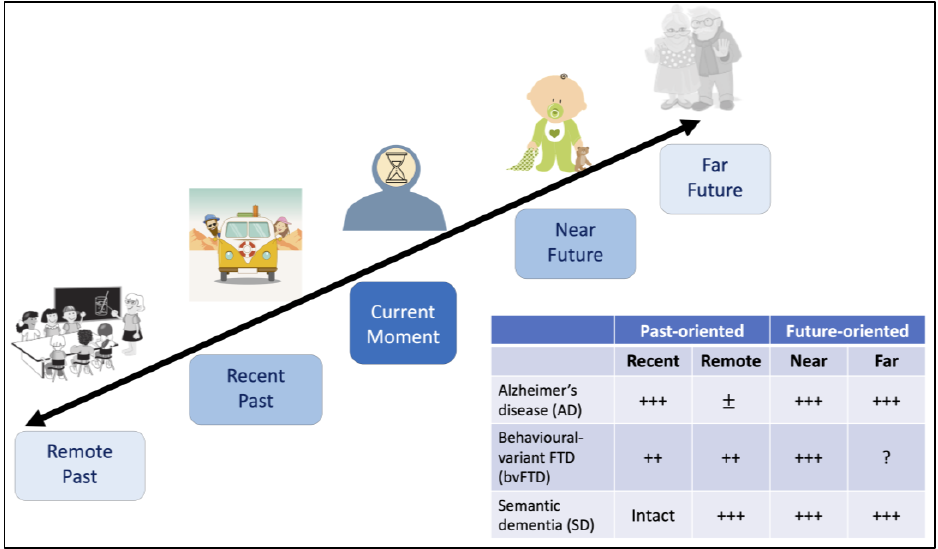
Figure 4. Bending time’s arrow—mental time travel allows us to revisit past experiences and to envisage possible future events, and is markedly compromised in dementia. Schematic showing how temporal distance from the current moment influences past retrieval and future thinking in healthy young adults. Images sourced from Pixabay.com (accessed on 22 March 2021). The accompanying table summarises the existing literature on mental time travel disturbances in dementia. Notes. ++: moderate impairments; +++: severe impairments; ± : variable performance depending on method of assessment; Intact: not significantly different to healthy older control performance; ?: no empirical data available to